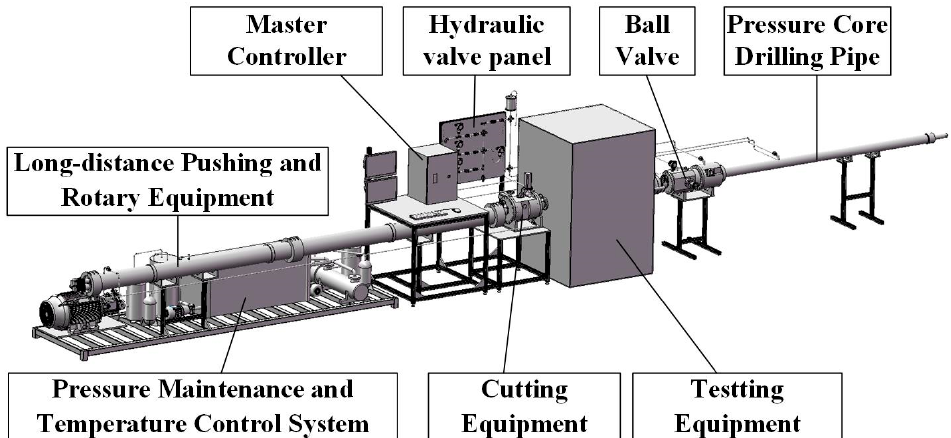
Figure 1. The analysis and transfer system of the natural gas hydrate pressure core.